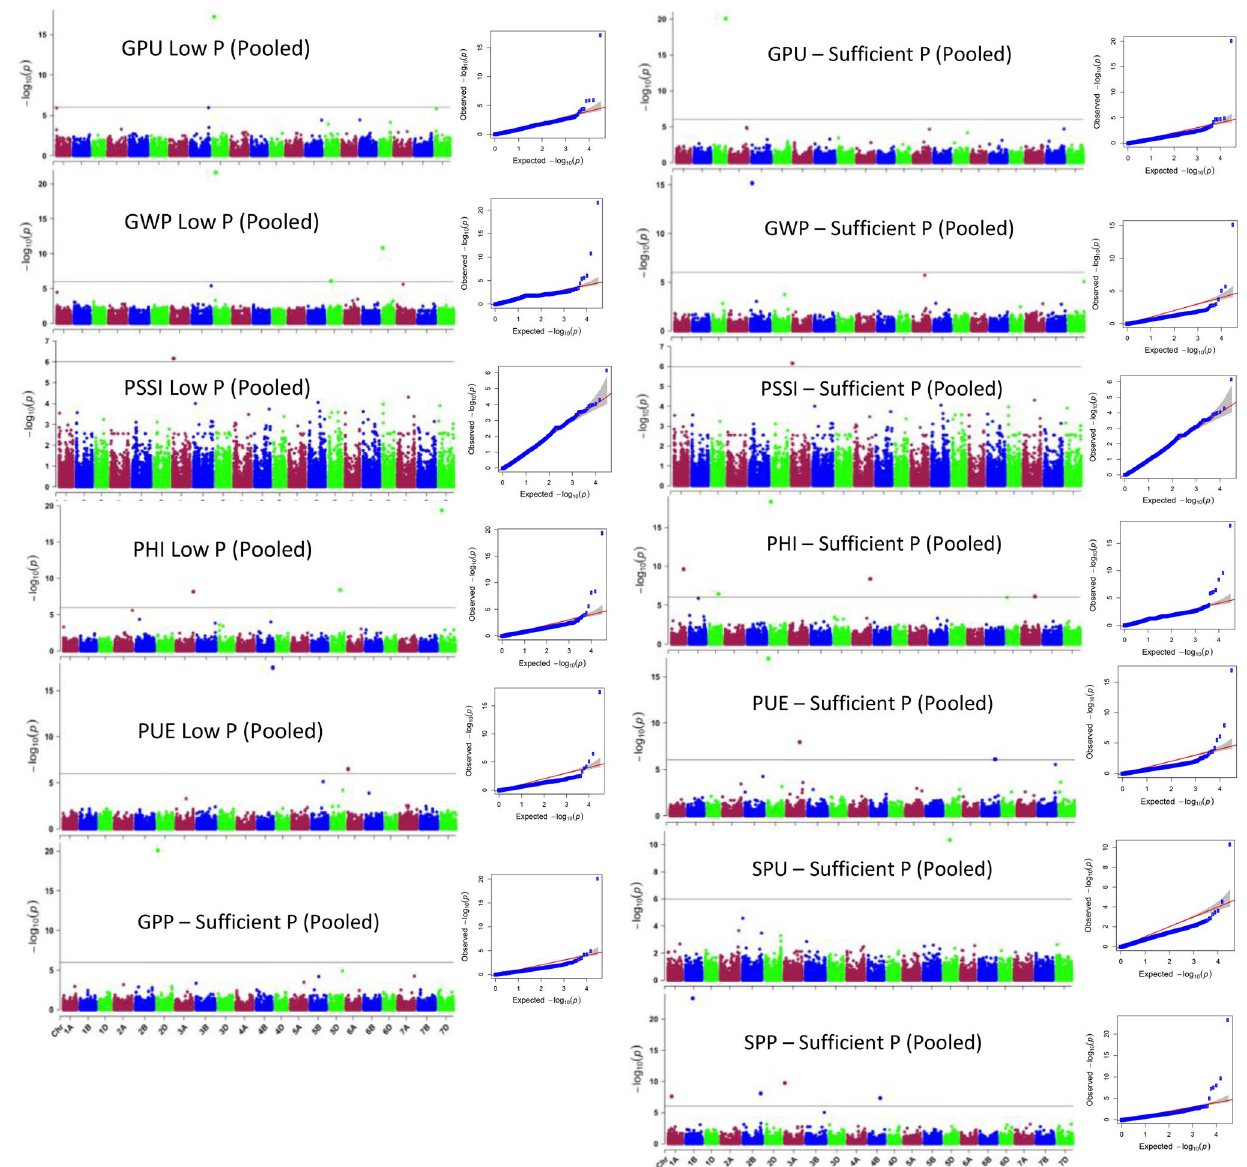
Figure 5. Manhattan plots showing SNP markers associated with different traits and Quantile–Quantile plots for 82 bread wheat accessions grown in low P soil using data pooled for two years. The horizontal line represents FDR adjusted p < 0.001. The threshold of -log 10 ( P -value) ≥ 6.0 was used as a cutoff to identify association analysis. Abbreviations: GPU, grain P uptake; GWP, grain weight per plant; PSSI, P stress susceptibility index; PHI, P harvest index; PUE, P use efficiency; GPP, grain P percentage; SPU, Shoot P uptake; SPP, shoot P GPU. GWP) and six MTAs controlling two traits (AX-94472688 on 2B: SPP, TBM; AX-94840782: GPU, TBM; AX-95126535: SPP, GWP; AX-94459431 on 5D: PUE, SPU; AX-94585983 on 6D: GPU, GWP and AX-95085037: SPU, TBM) (Fig. 7A). A total of 297 unique genes within 0.50 Mbp region (0.25 Mbp on both the sides of each MTA) of the 35 MTAs were identified. Out of 297, protein functions were available for 254 candidate genes which mainly belonged to carbohydrate metabolic process, fatty acid biosynthesis, protein phosphorylation/ dephosphorylation, vascular/ transmembrane/protein transport and nucleotide biosynthetic process (Supplementary Table S13). The SNP tag sequence of six of nine multi-trait MTAs had 100% identity with high confidence wheat genes (included in 297 genes) which encode proteins for CTP synthase, importin-beta, FAD/NAD(P)-binding domain, Tetratricopep- tide-like helical domain, protein binding domain and Ser/Thr kinase which were involved in CTP synthesis, protein transport, oxidation–reduction, hydrolase activity, protein binding and signal transduction, respectively (Supplementary Table 13).